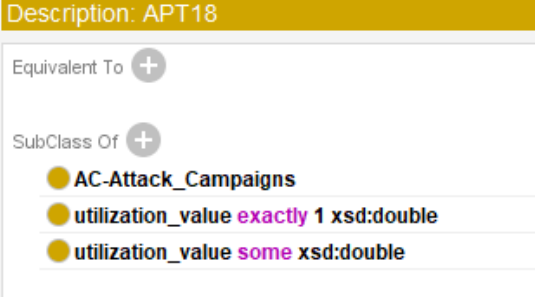
Figure 6. Utilization value of the retained